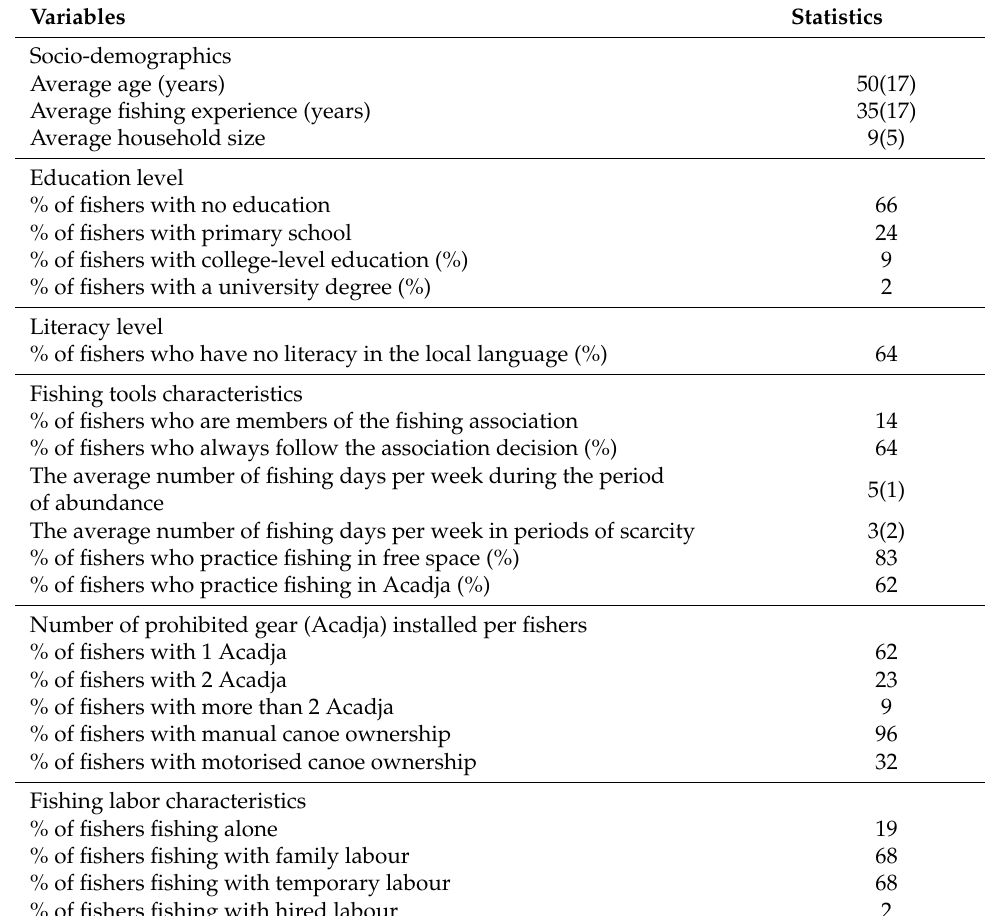
Table 5. Fishers’ socio-demographic and fishing characteristics (standard deviation in between